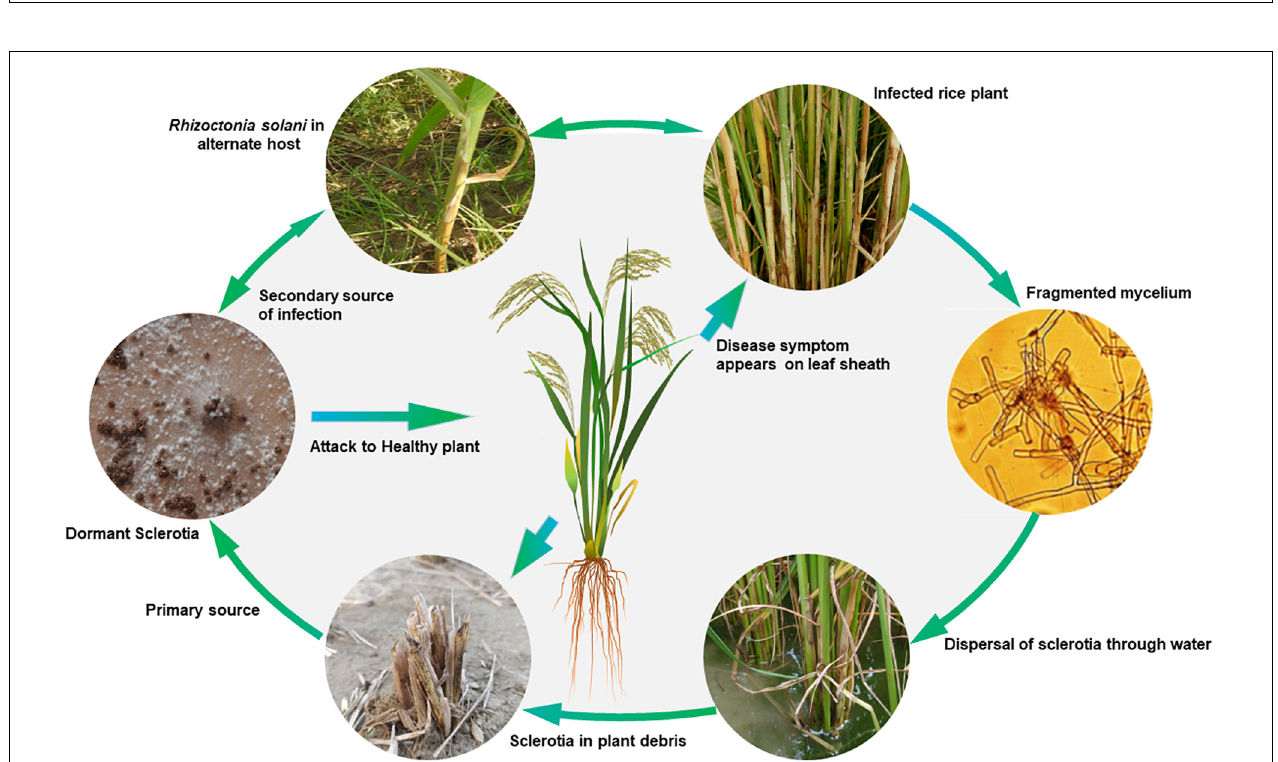
FIGURE 2 | Disease cycle of sheath blight of rice caused by Rhizoctonia solani AG1-IA.